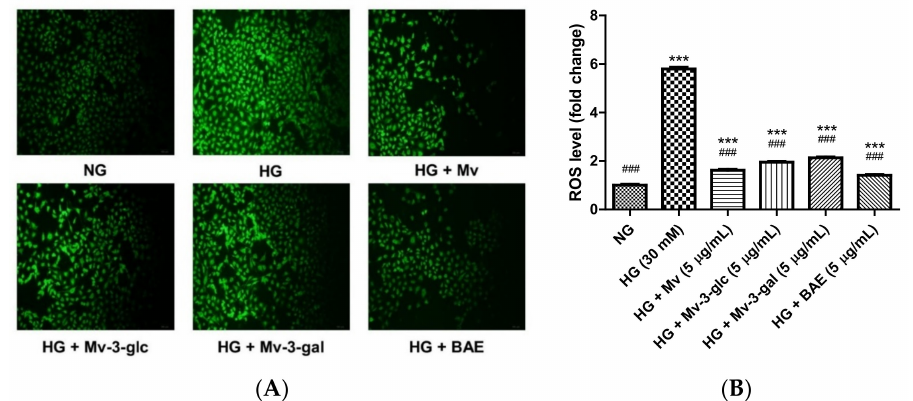
Figure 2. E ff ects of Mv, Mv-3-glc, Mv-3-gal, and BAE on reactive oxygen species (ROS) level in HUVECs exposed to high glucose for 24 h: ( A ) The fluorescence intensity ( B ) ROS fold change. A representative set of images from three independent experiments is shown. All images presented are in × 200 magnification. Bars represent mean values ± SD ( n = 3). *** indicates p < 0.001 compared with the control NG; ### indicates p < 0.001 compared with the HG